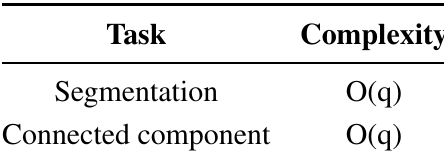
Table 1. Complexity of preprocessing steps. q denotes the number of pixels in an